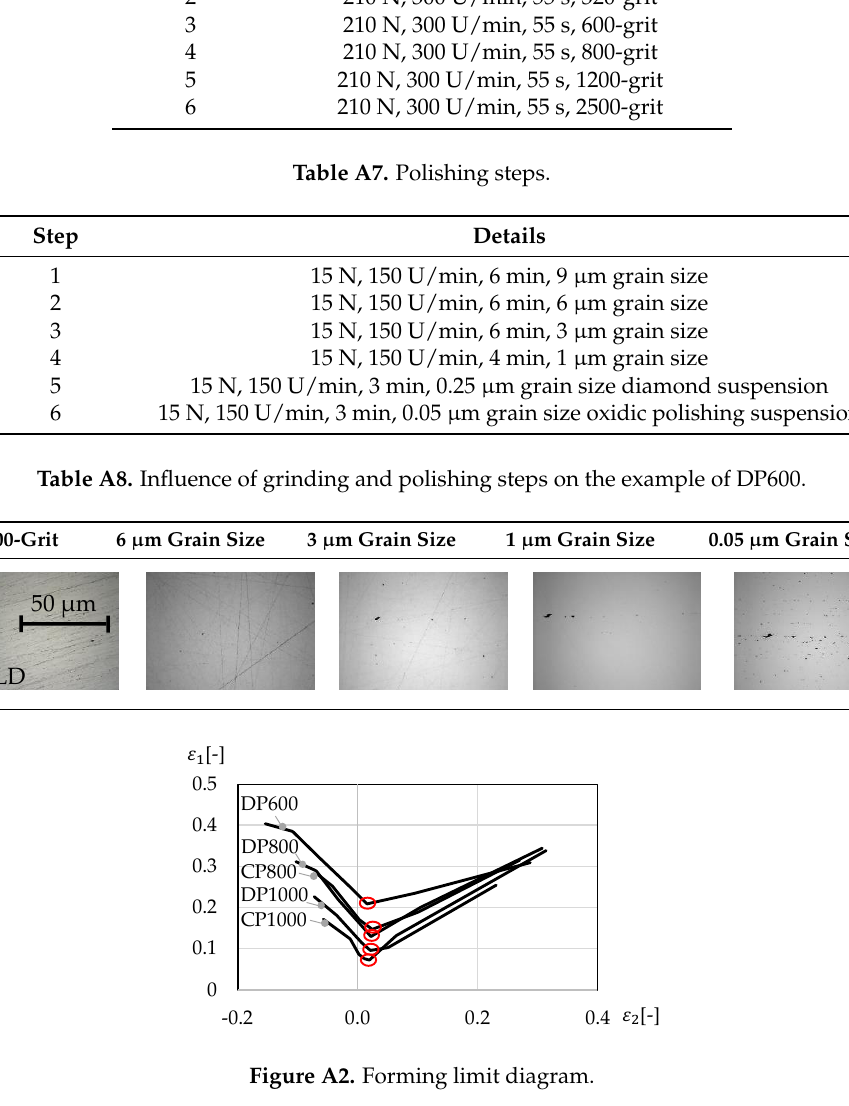
Table A7. Polishing steps.